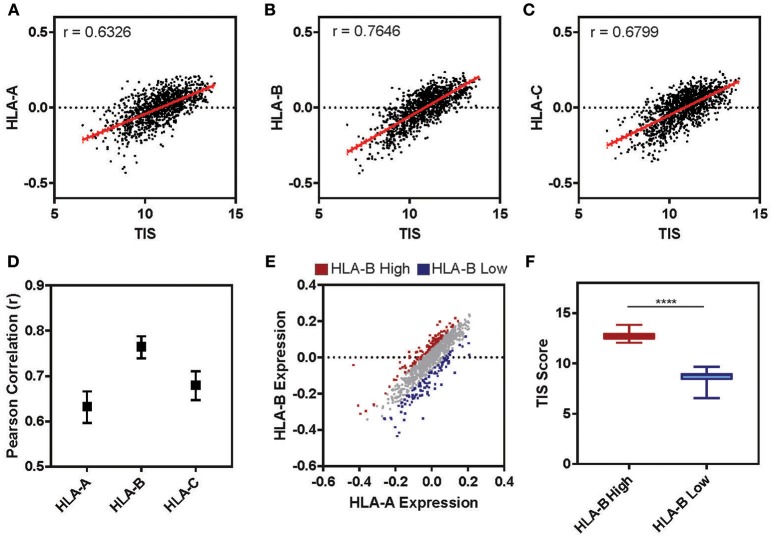
Tumor Inflammation Signature correlates with relative levels of HLA-B across patients. (A–C) The relative expression of HLA-A (A), HLA-B (B), or HLA-C (C) (normalized to the mean expression for that gene in the cohort and log2 transformed) is plotted against the tumor inflammation signature (TIS). The Pearson correlation (r) for these two parameters across the full TCGA lung cohort (n = 1,128) is displayed on the graph. (D) The Pearson correlation for the analysis presented in (A–C). Upper and lower limits on the correlation are indicated by bars. (E) The relative expression of HLA-A is plotted against HLA-B for the cohort (n = 1,128). Each sample was ranked by the difference between HLA-B and HLA-A expression and the 10% at the top (HLA-B high) and bottom (HLA-B low) of the ranking are marked in red and blue, respectively. (F) The mean TIS score for the two subsets defined in E are displayed. The HLA-B high subset has a significantly higher average TIS score (Mann Whitney, two tailed T-test, ****p < 0.0001; whiskers indicate min and max).